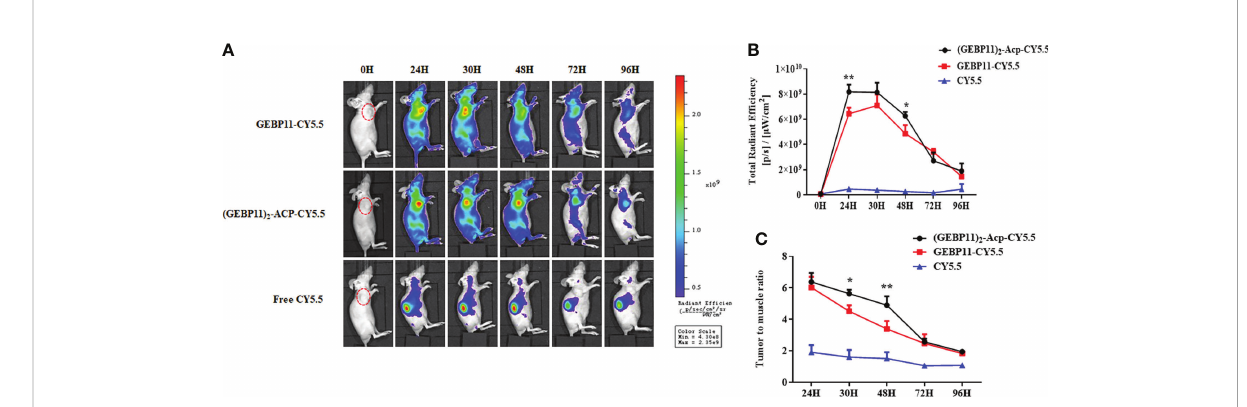
FIGURE 2 NIR fl uorescent imaging of GEBP11 series probes in subcutaneous tumor models. (A) In vivo continuous observations (0-96h) of SGC7901 bearing xenografts after intravenous administration of series probes by IVIS imaging system. (GEBP11) 2 -ACP-Cy5.5 probe exhibited more speci fi c tumor targeting and longer retention, while the fl uorescence signal mainly focused on kidney in the negative control (Free Cy5.5) group. (B) Dynamic changes of total fl uorescence signal in the tumor site. (C) Comparison of tumor-to-muscle ratio of different probes. All data were expressed as mean ± SD. * p < 0.05; ** p <